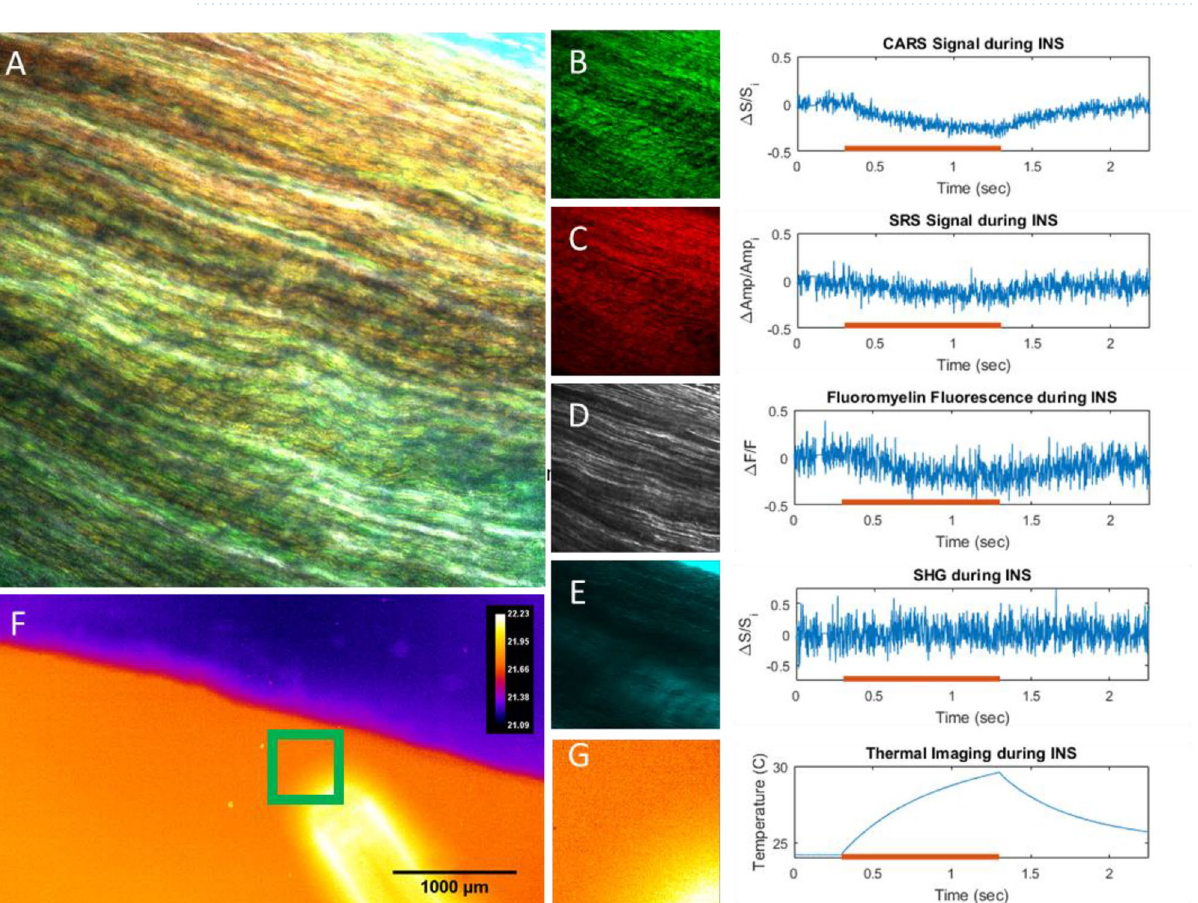
Figure 4. Ex vivo rat sciatic nerve samples imaged with high-speed multimodal nonlinear and thermal microscopy. ( A ) Combined image of B-E. Images and corresponding high-speed line scans through the centers of the fields of view with ( B ) CARS at 2880 cm −1 . ( C ) SRS at 2880 cm −1 , ( D ) FluoroMyelin Green, ( E ) SHG. Red lines on graphs indicate the exposure of the tissue to 1875 nm light from an optical fiber. Light exposure causes a local temperature increase over 1 s (thermal images, ( F ) and ( G )) yielding a corresponding decrease in nonlinear